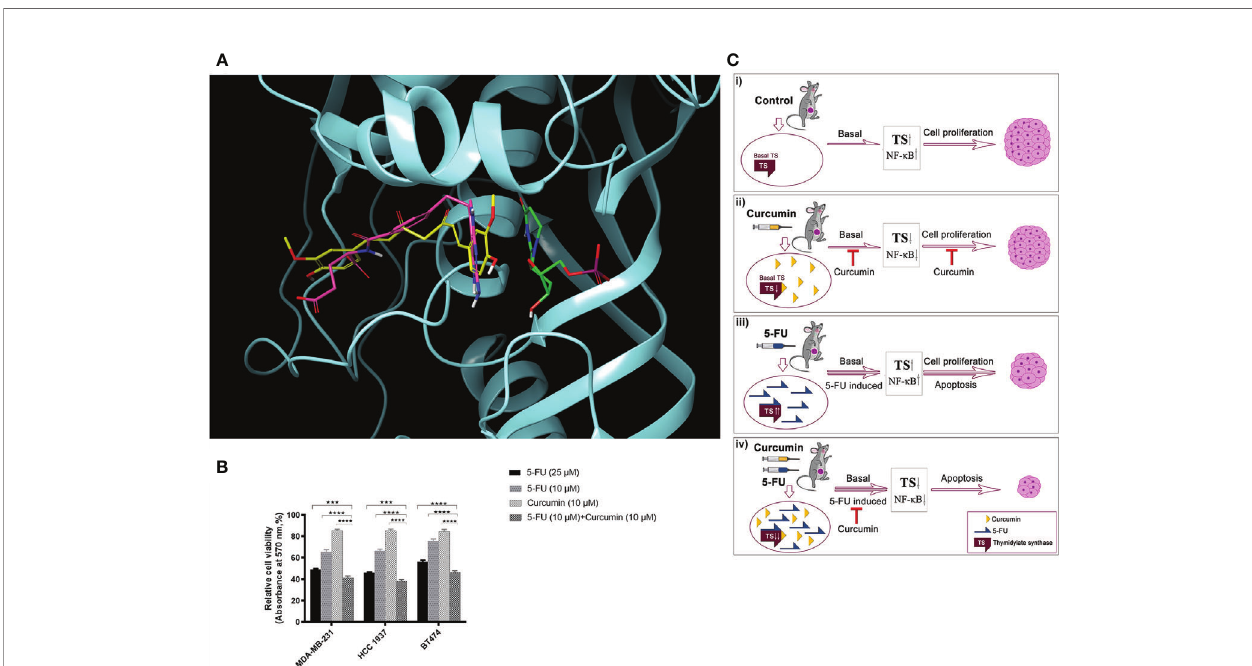
FIGURE 6 | Docking analysis of curcumin binding on TS (A) Docking analysis of curcumin binding on TS. Comparative binding pose of Curcumin (yellow), LY231514 (pink), and FdUMP (green) at the catalytic center of TS generated by molecular docking studies. Curcumin and LY231514 span the cofactor binding site of TS whereas FdUMP binds the substrate binding site. Protein is displayed in cartoon style and ligands are represented as tubes. (B) Effect of 5-FU and curcumin, alone or in combination, on breast cancer cells of different receptor status. A total of 5000 cells in triplicates were exposed to the indicated concentrations of the drugs for 48 h and subjected to 3-(4,5-dimethylthiazol-2-yl)-2,5-diphenyltetrazolium bromide (MTT) assay. Relative cell viability was determined as percentage absorbance over untreated control. Data represent three independent sets of experiments and results are shown as the mean ± S.D. **** and *** represents P-values ≤ 0.0001 and ≤ 0.001 respectively. (C) A schematic representation of 5-FU-curcumin synergism against breast tumor progression. i The mammary tumors induced in NSG mice exhibit an up-regulation of key anti-apoptotic factors like TS and NF- k B, which promotes cell proliferation leading to BC progression. ii Phytochemical curcumin impedes the activation of these factors by binding to TS and thereby chemosensitizing the tumor cells making it susceptible to programmed cell death. iii 5-FU, the widely used anti-cancer drug, elicits signi fi cant apoptosis of tumors cells by its mechanism of action though in parallel it elevates the activation of various survival signals and key cell proliferative factors including TS enzyme causing drug-induced chemoresistance as a side-effect. iv The combinatorial administration of curcumin along with 5-FU attenuates the drug-induced augmentation of TS and the downstream anti-apoptotic regulators that promote chemoresistance and subsequently lead to cell death resulting in drastic tumor regression and thereby functions as an ef fi cient therapeutic regimen against all BC types irrespective of their receptor